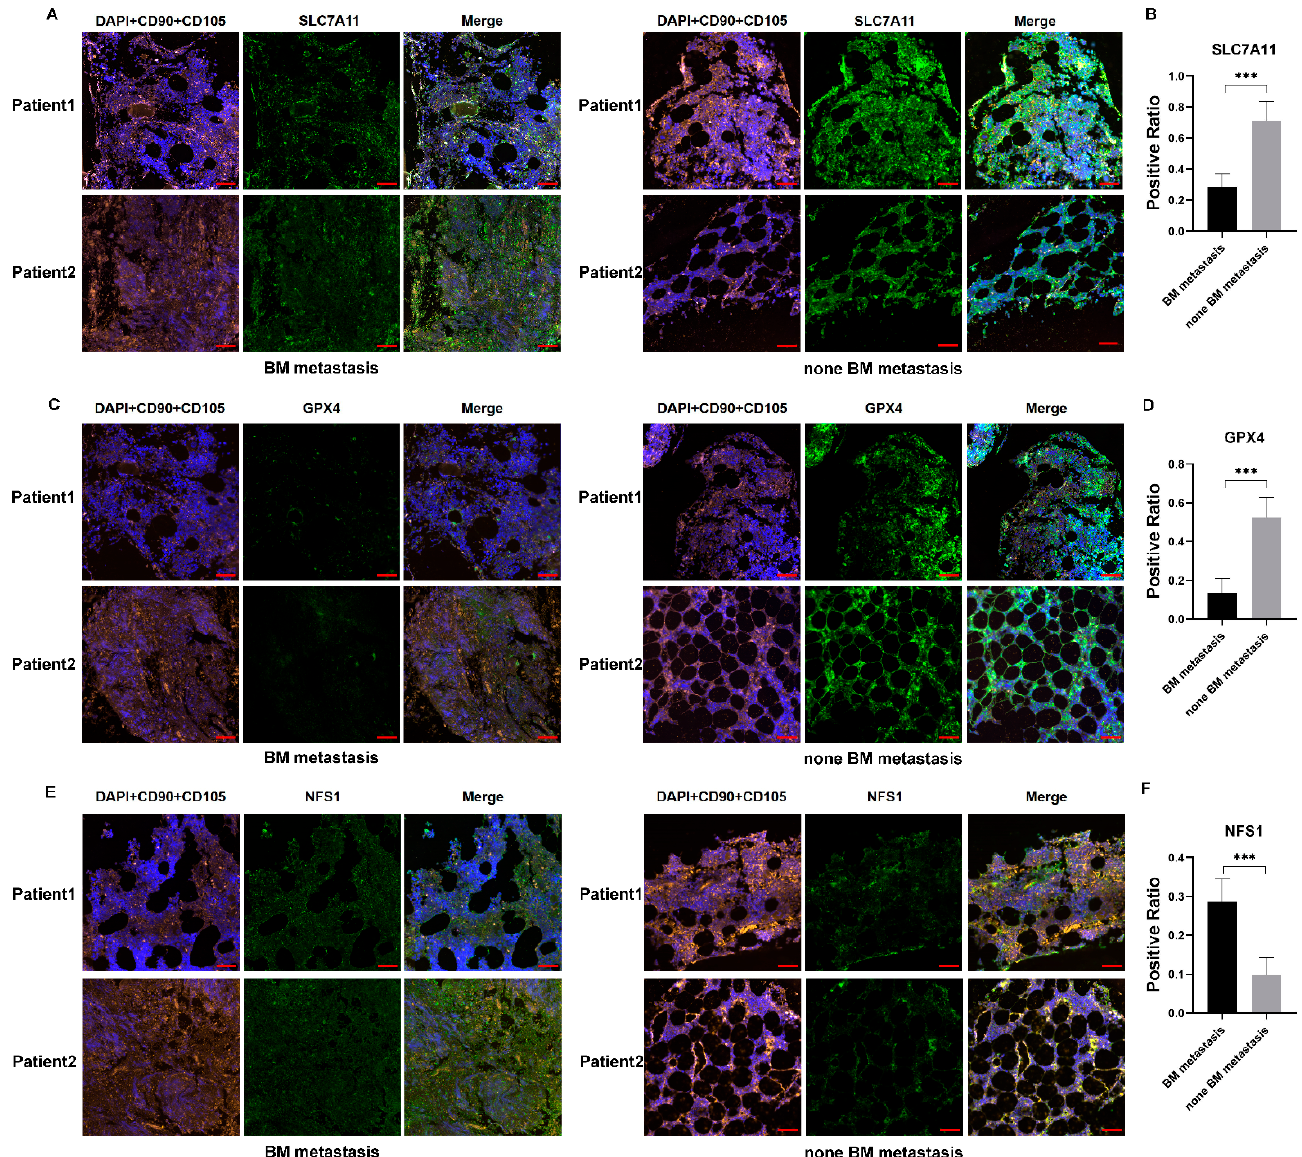
Figure 7. Immunofluorescence indicated decreased anti-ferroptosis capacity of BMSCs in patients with BM metastasis. ( A – F ) CD90 and CD105 were used to mark BMSCs; SLC7A11, GPX4, and NFS1 were detected in BM of NB patients with or without BM metastasis. Scale bar: 50 µ m. Student’s t -test was used in the analysis. *** p < 0.001.